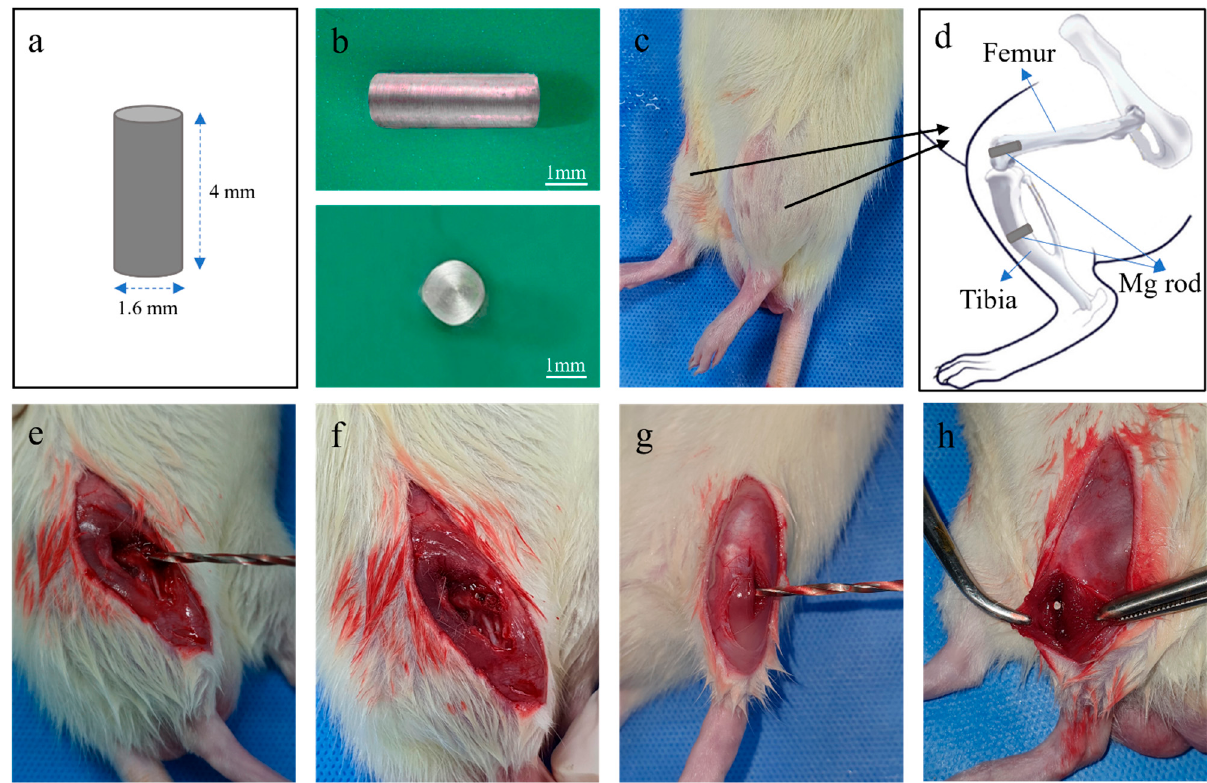
Figure 1. Cylinder rod type of the implant and position for in vivo test. ( a , b ) Schematic diagram and optical images of the magnesium implant used for the experiment, ( c , d ) sketch of 4-implant position at both rat’s lower limbs, ( e , f ) implant placement at distal femur, and ( g , h ) implant placement at tibia shaft.